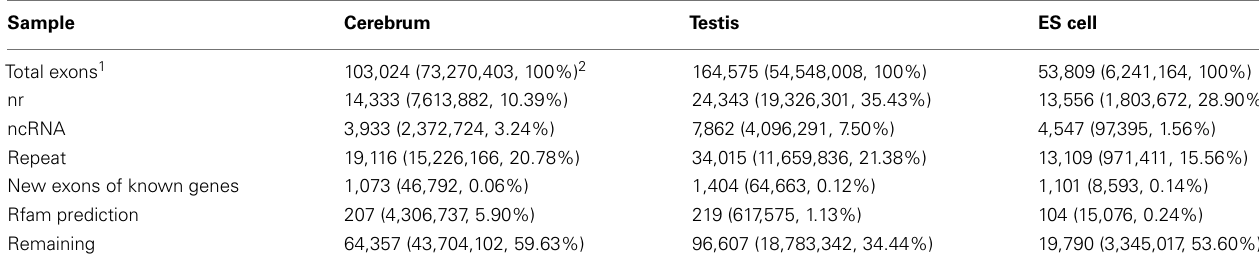
Table 2 |The exon annotation based on Refgene intron (filtered) and intergenic regions.